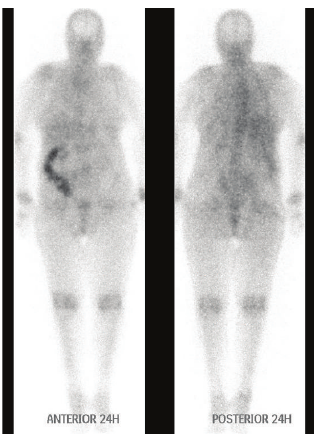
Figure4:Onemonthlaterandafterappropriatetreatmenttherewas a total absence of gallium-67 concentration in the ascending